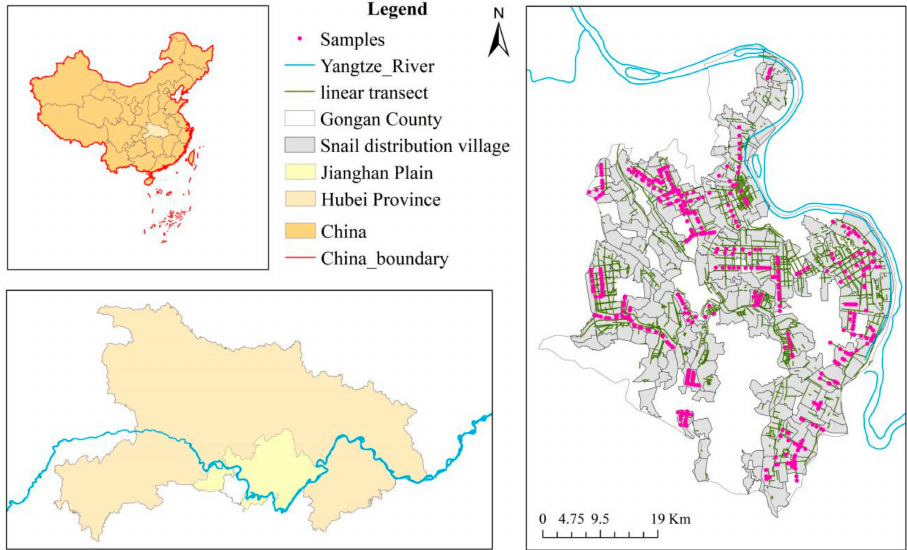
Figure 1. Location of the study area in China and O. hupensis snail